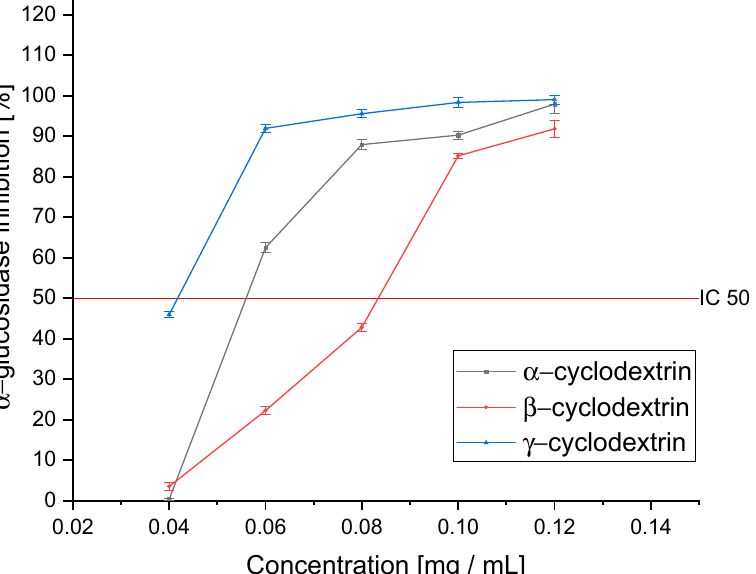
Figure 6. The ability of the extracts obtained using selected cyclodextrins to inhibit α -glucosidase. Significance at p ≤ 0.05.